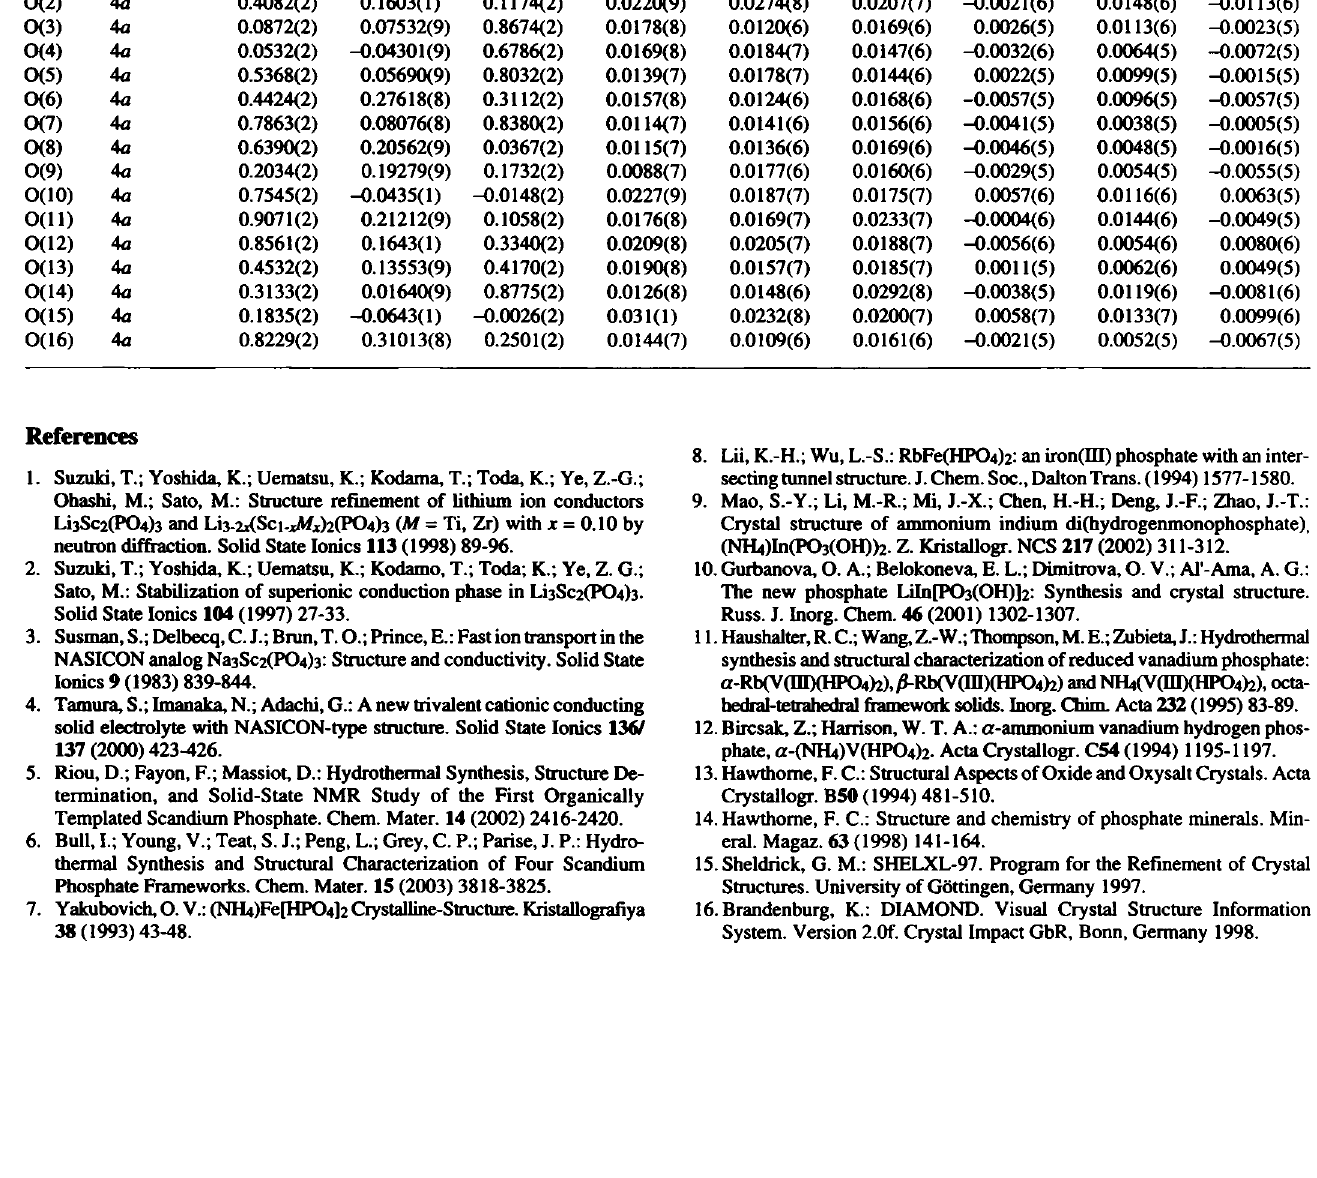
Table 3. Atomic coordinates and displacement parameters (in Â 2